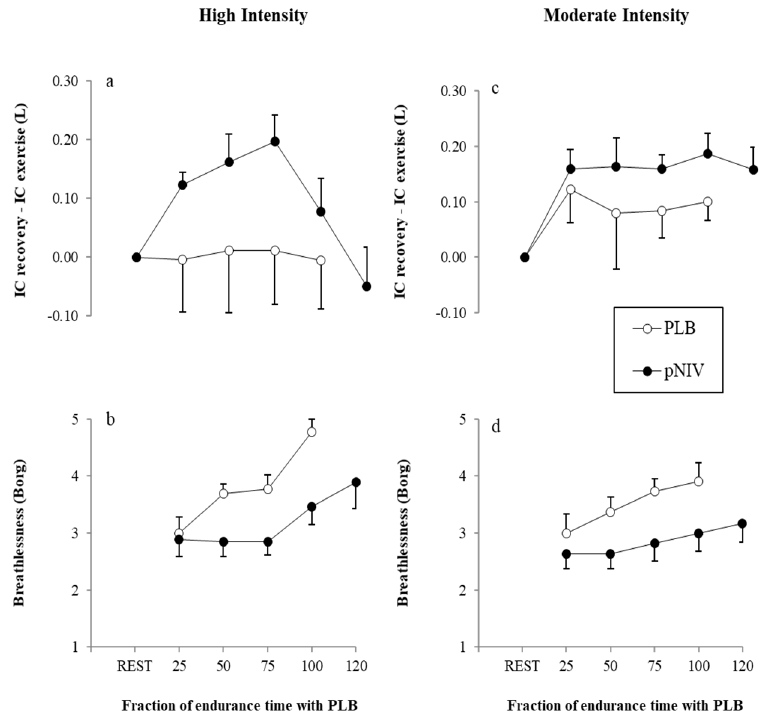
Figure 4. E ff ect of the application of pNIV (closed circles) compared to PLB (open circles) on inspiratory capacity calculated as the change between recovery periods and the end of high-intensity intermittent ( a ) or moderate-intensity ( b ) and moderate-intensity ( c ) exercise bouts and symptoms of breathlessness during recovery from high-intensity ( d ) exercise. Responses are shown for both PLB and pNIV at iso-time across the four percentiles (25%, 50%, 75% and 100%) of the total endurance time when using the PLB technique. Data are presented as mean ± standard error of the mean